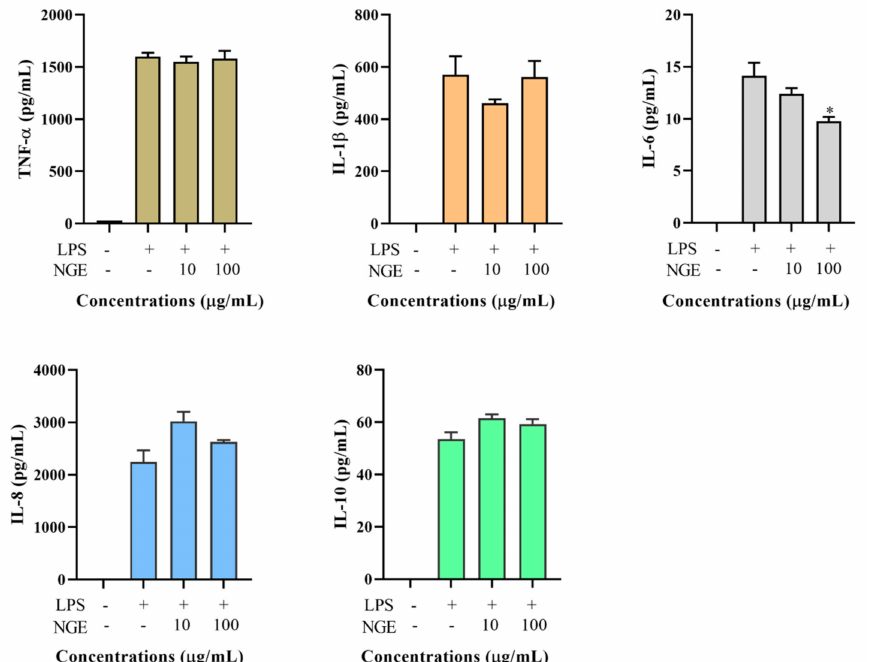
Figure 4. Effect of TGE on LPS-induced TNF- α , IL-1 β , IL-6, IL-8, and IL-10 productions in the THP-1 cell culture medium. Data are shown as the mean ± SD of three repetitions. * p < 0.05 for comparison of LPS stimulation with and without ginseng extract